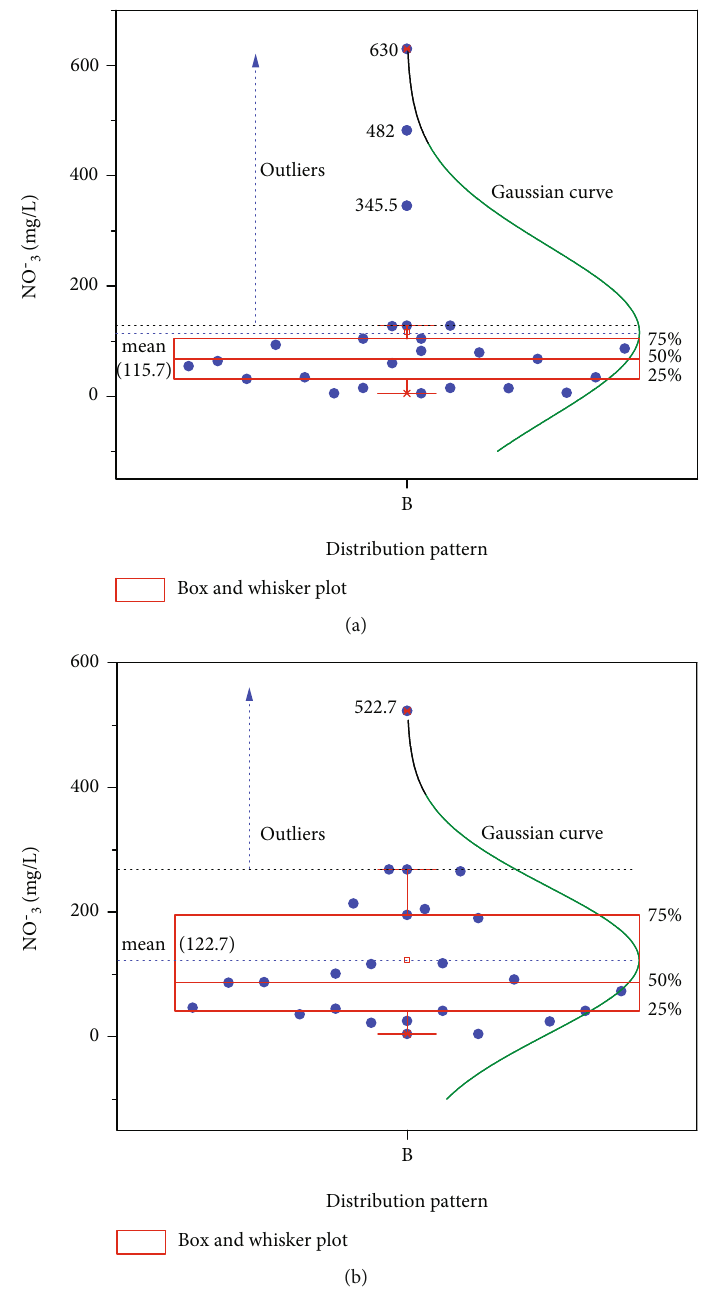
Figure 6: Outlier analysis showing nitrate distribution patterns in boreholes during the (a) wet and (b) dry